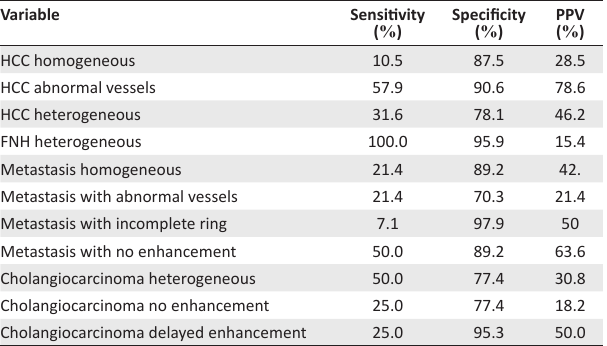
TABLE 1: Diagnoses and corresponding enhancement.